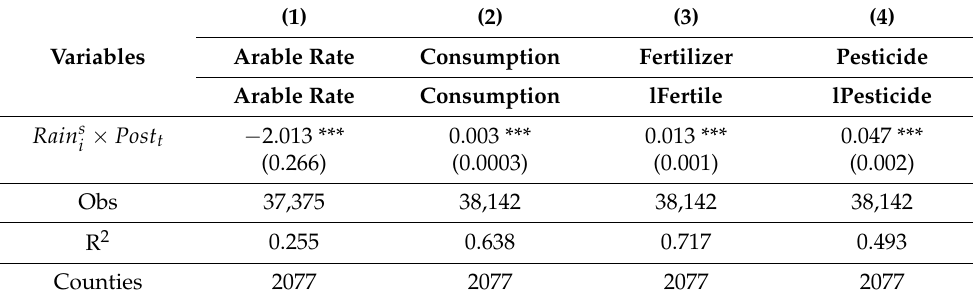
Table 9. Mechanism analysis of the snow disaster on